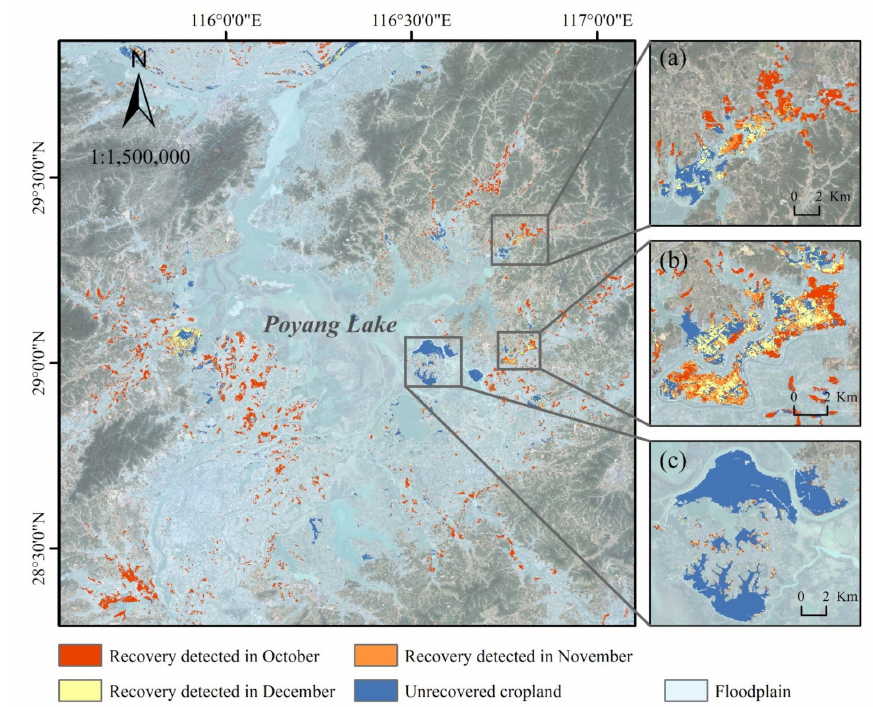
Figure 10. Spatial and temporal patterns of agricultural recovery around the Poyang Lake. The zoom-in maps highlight different distributions of recovered cropland owing to diverse stricken geographical locations: ( a ) recovered from away to close to the Poyang Lake; ( b ) recovered from outer to inner side of a polder; ( c ) unrecovered cropland as encircled by lake water. Figure 9 exhibits the spatial pattern of agricultural recovery around the Chao